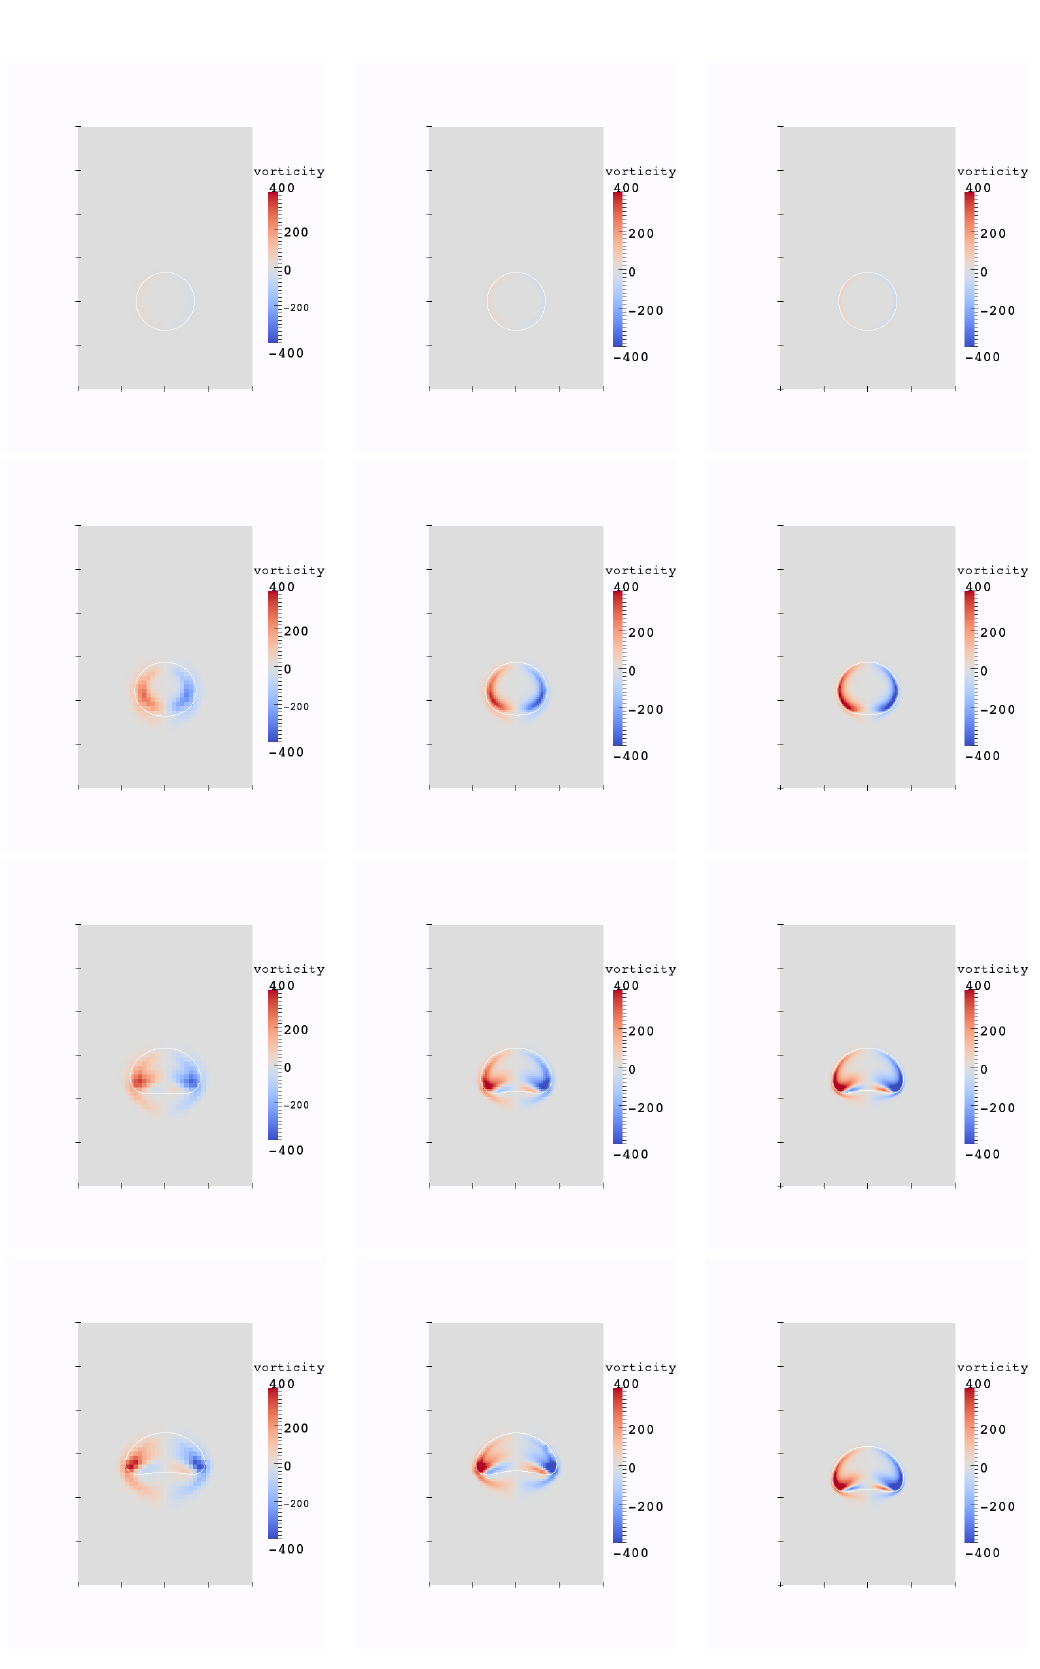
Figure 9. Evolution of the interface and vorticity values for the small bubble test case, at times 0, 0.02, 0.035, 0.05, resolution: 40 × 60 ( left ); 80 × 120 ( middle ); 160 × 240 ( right